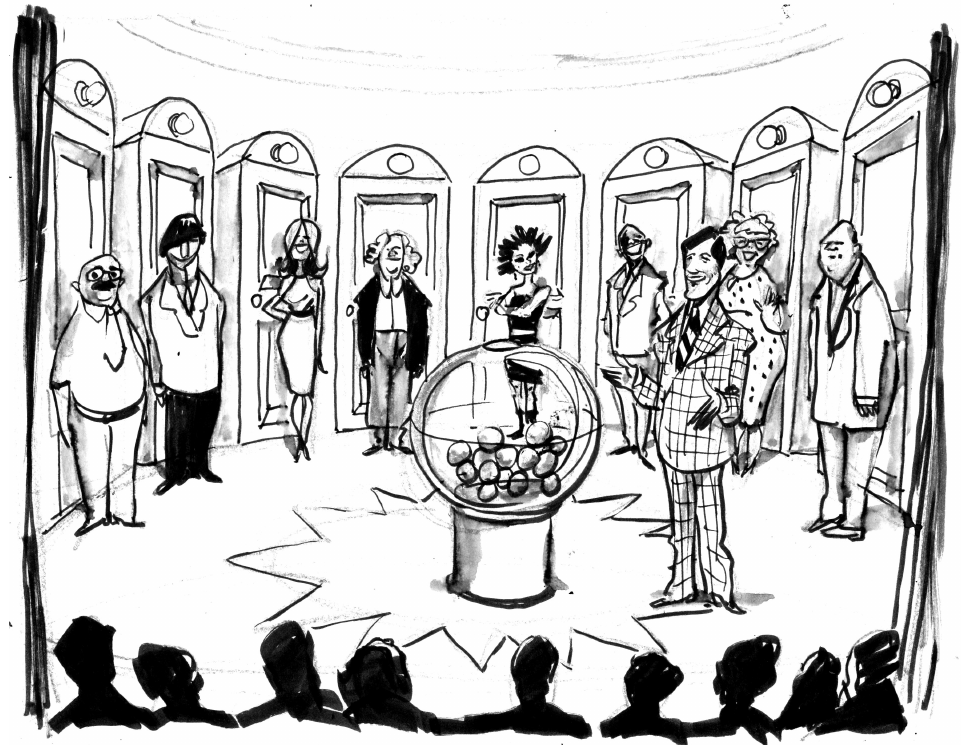
Figure 1. Game show with Monty Hall, eight potential contestants, eight soundproof booths and a lottery ball machine as the stochastic device (Drawing by Laurent